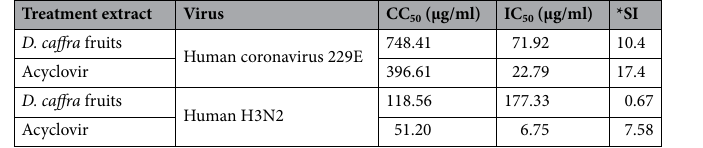
Table 4. Antiviral activity of D. caffra fruits extract against Human coronavirus 229E and human H3N2.